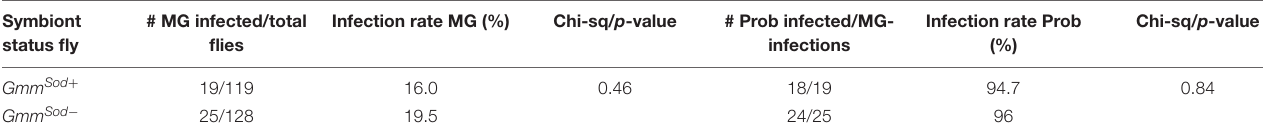
TABLE 2 | Trypanosome infection outcome in tsetse fly midguts (MG) and proboscis (prob) of symbiotic ( Gmm Sod + ) and S. glossinidius -free ( Gmm Sod − ) flies that were given a Trypanosoma congolense -parasitized blood meal when they were newly emerged, 1 day post-eclosion. Symbiont status